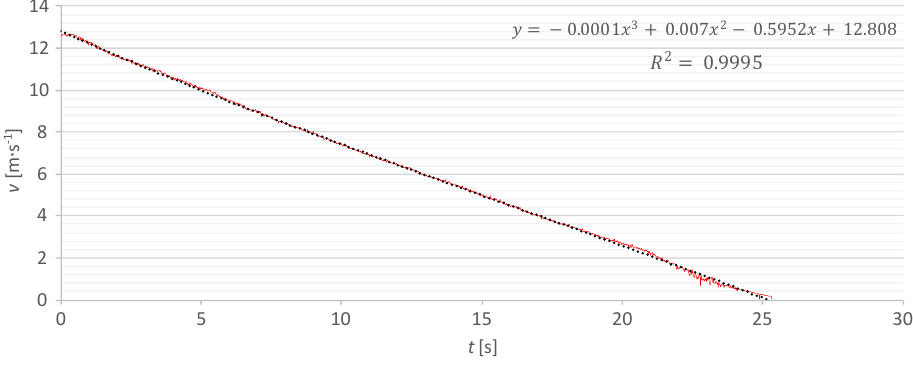
Figure 11. Biro Speed during the coast down